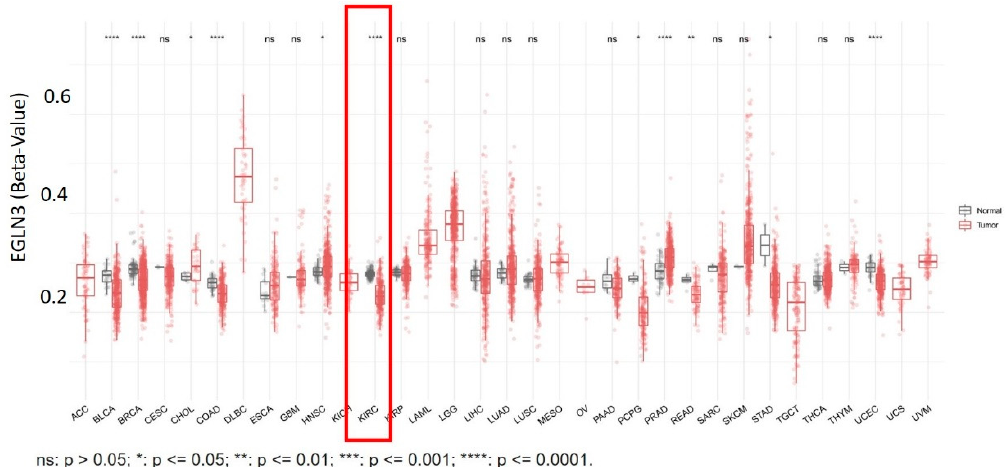
Figure A3. Methylated CpGs in the EGLN3 gene in different cancers (red) compared to normal tissue (gray). The red box highlights the difference in methylation of EGLN3 in kidney cancer (KIRC) versus normal tissue ( p ≤ 0.0001). Figure generated using http://www.bioinfo-zs.com/smartapp/ on 10 September 2020 [25].